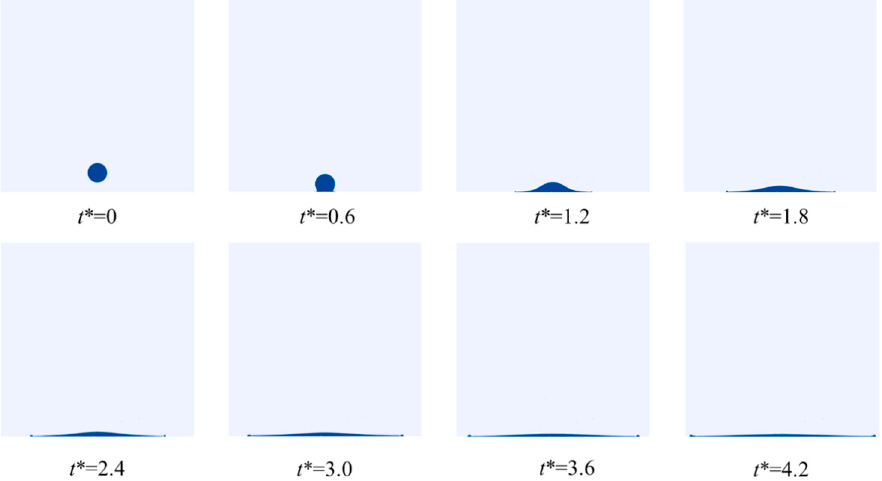
Figure 13. The spreading process of the oil droplet impinging the smooth wall.